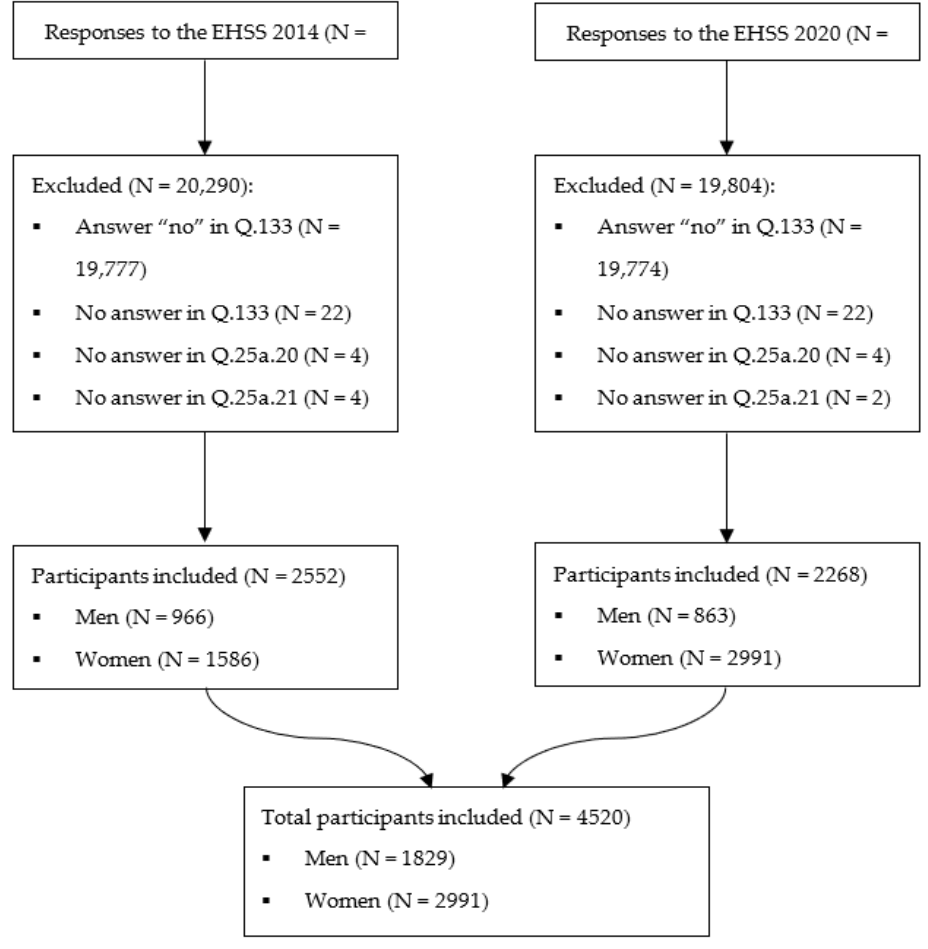
Figure 1. Selection process flowchart.